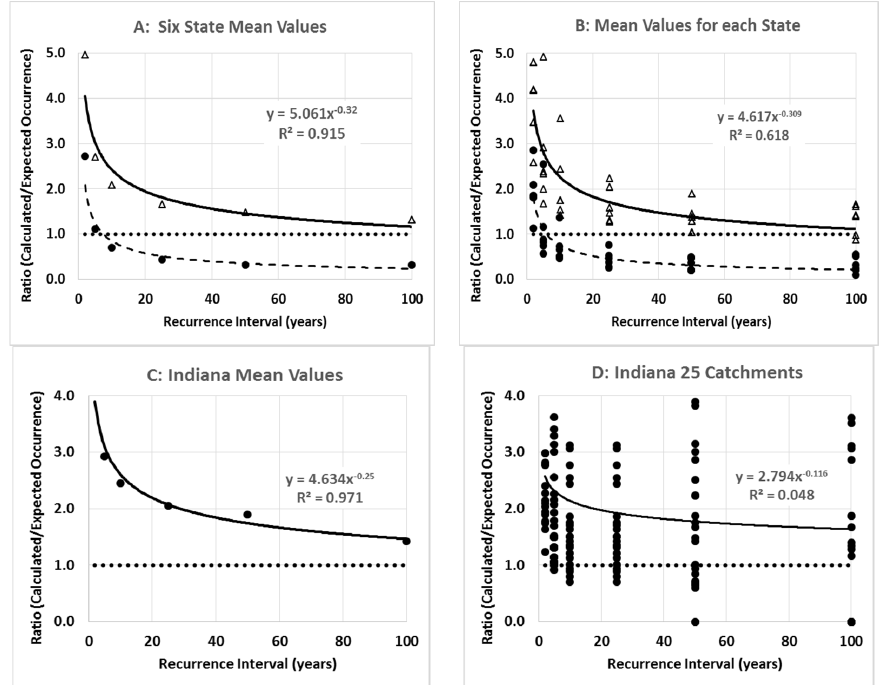
Figure 3. Plots of the ratios of the calculated versus expected occurrences based on the mean discharge of all 25 catchments evaluated for each state (solid triangles). A regression relationship through this data is shown as a solid line together with the relationship and R-squared value. Solid circles and dashed lines are associated with occurrence ratios based on 125% of the discharges calculated with the Log-Pearson Type 3 analysis.